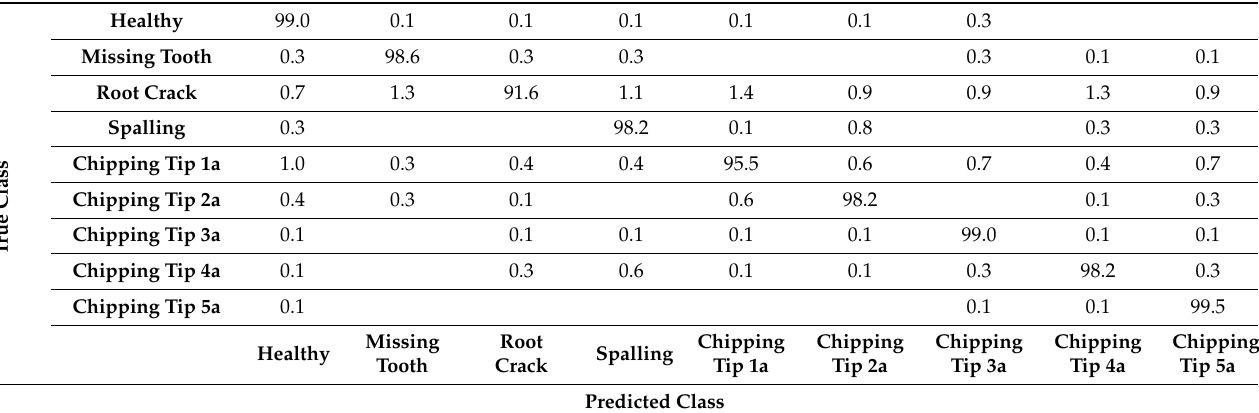
Table 9. Confusion matrix for LWSN for the UoC